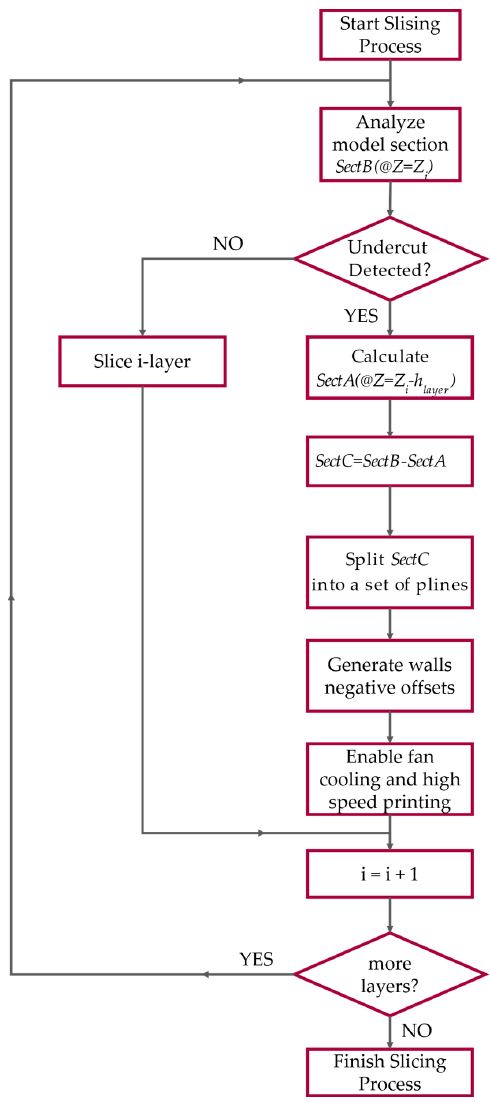
Figure 5. Flowchart of proposed algorithm.